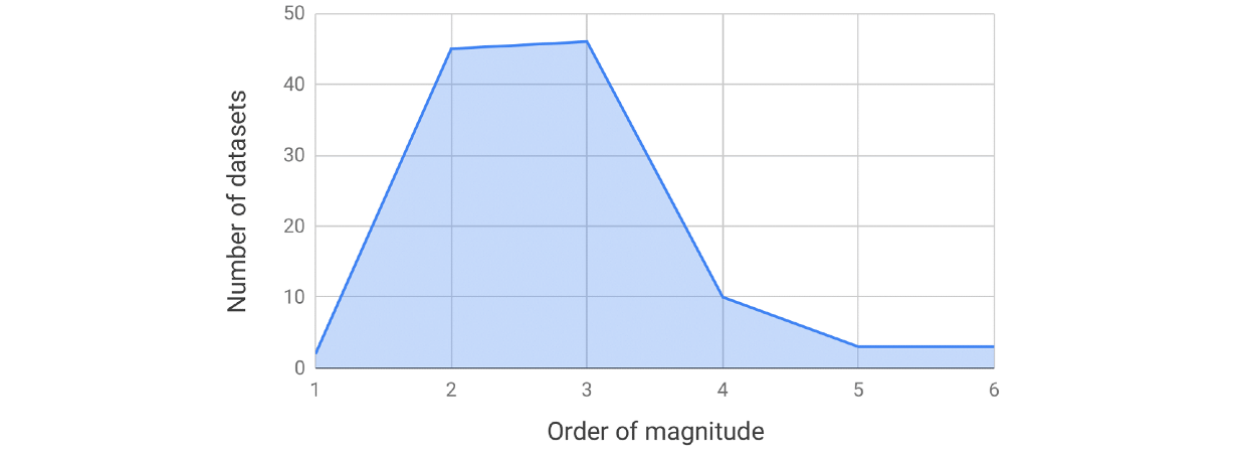
Figure 2. Distribution of data size on a logarithmic scale.